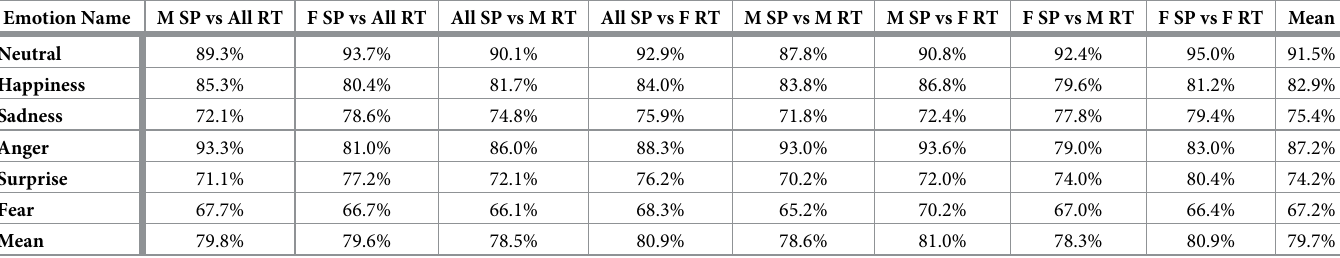
Table 9. Average recognition rates for males and females in Phase 2.